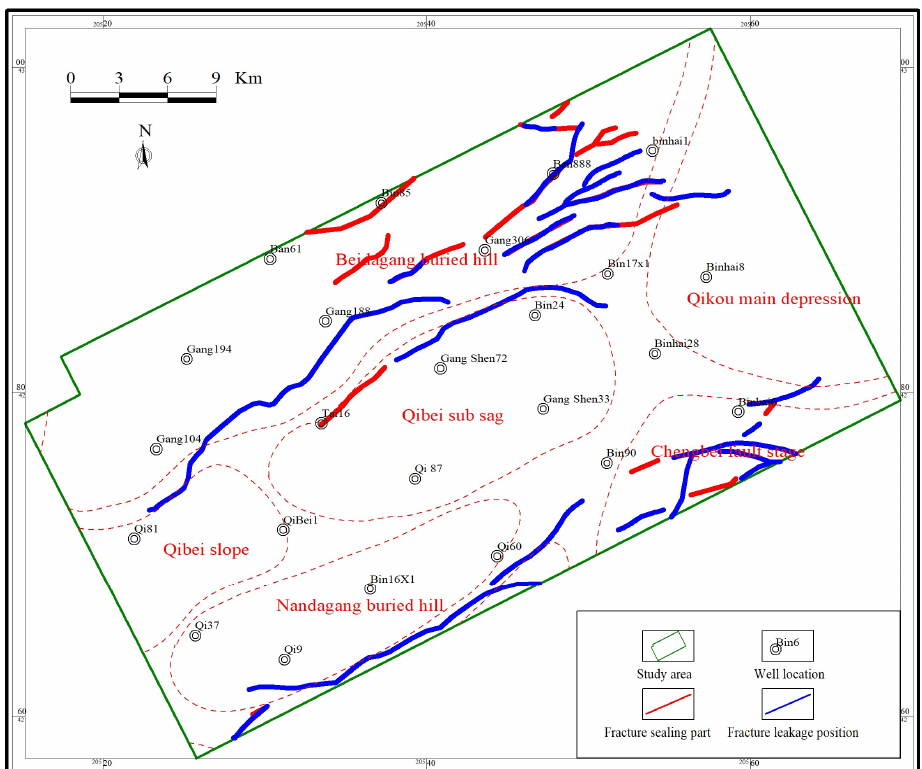
Figure 7. Distribution of fault-shale caprock configuration leakages at the middle part of Sha-1 Member in the south of the northern Dagang area.